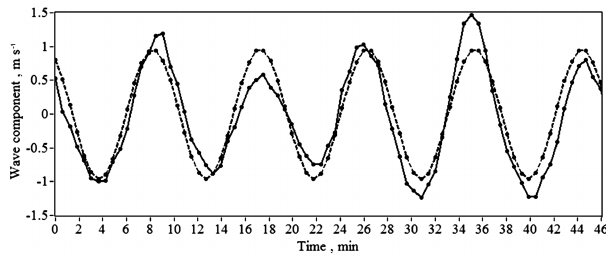
Figure 8. Time dependence of the wave addend of the longitudi- nal wind velocity: (solid curve) measurements by the Stream Line lidar starting from 14:20LT on 23 August 2015 at a height of 766.4ma.g.l. (the data of Fig.5a were used); (dashed curve) result of least-squares fitting of sine-wave dependence (6) for the wave addend e V x (t) to the measured data shown by the solid curve.